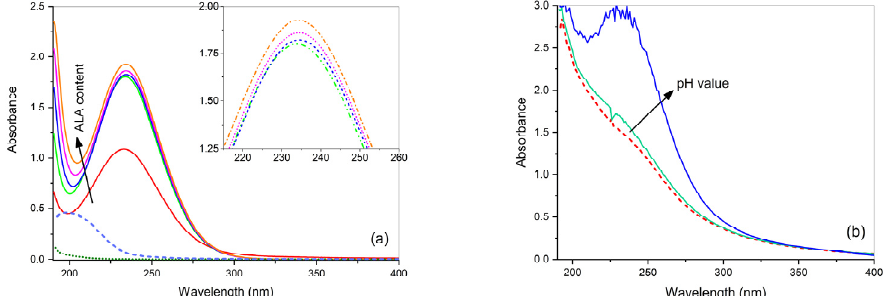
Figure 4. ( a ) UV-Vis absorbance spectra of free aqueous solutions containing CuSO 4 and alanine (ALA) at increasing M:L molar ratios (1:1, 1:2, 1:3, 1:4, and 1:5) at pH 10.0; the spectra of solutions of ALA (dotted curve) and CuSO 4 (dashed curve) are also reported for comparison. ( b ) UV-Vis ab- sorbance spectra of agar gels containing CuSO 4 and ALA in molar ratio 1:2 at increasing pH (3.4 and 10.0); the spectrum of agar gel containing only CuSO 4 is also reported for comparison (dashed curve). Gel samples are 1 mm thick and the optical path for solutions in the cuvette is 1 cm.